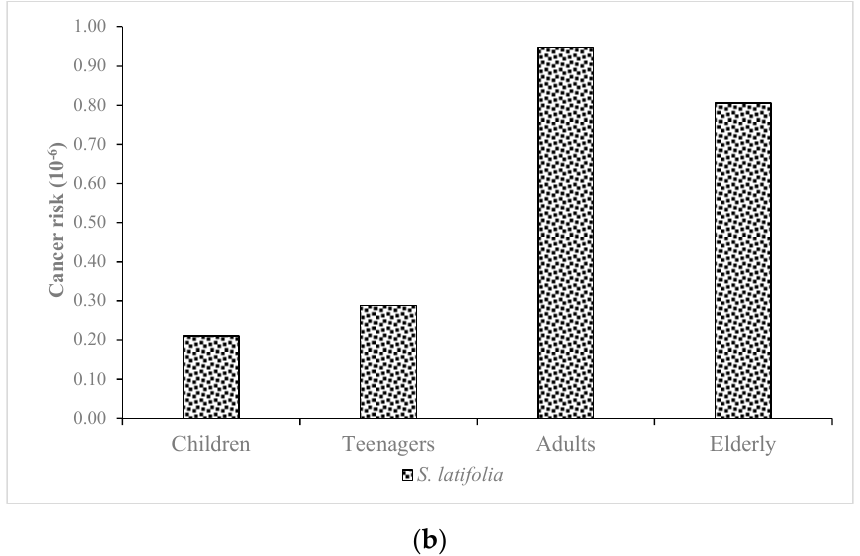
Figure 1. Cancer risk (CR) of Pb through dietary intake of L. Sativa and D. tenuifolia ( a ) and of S. latifolia ( b ).